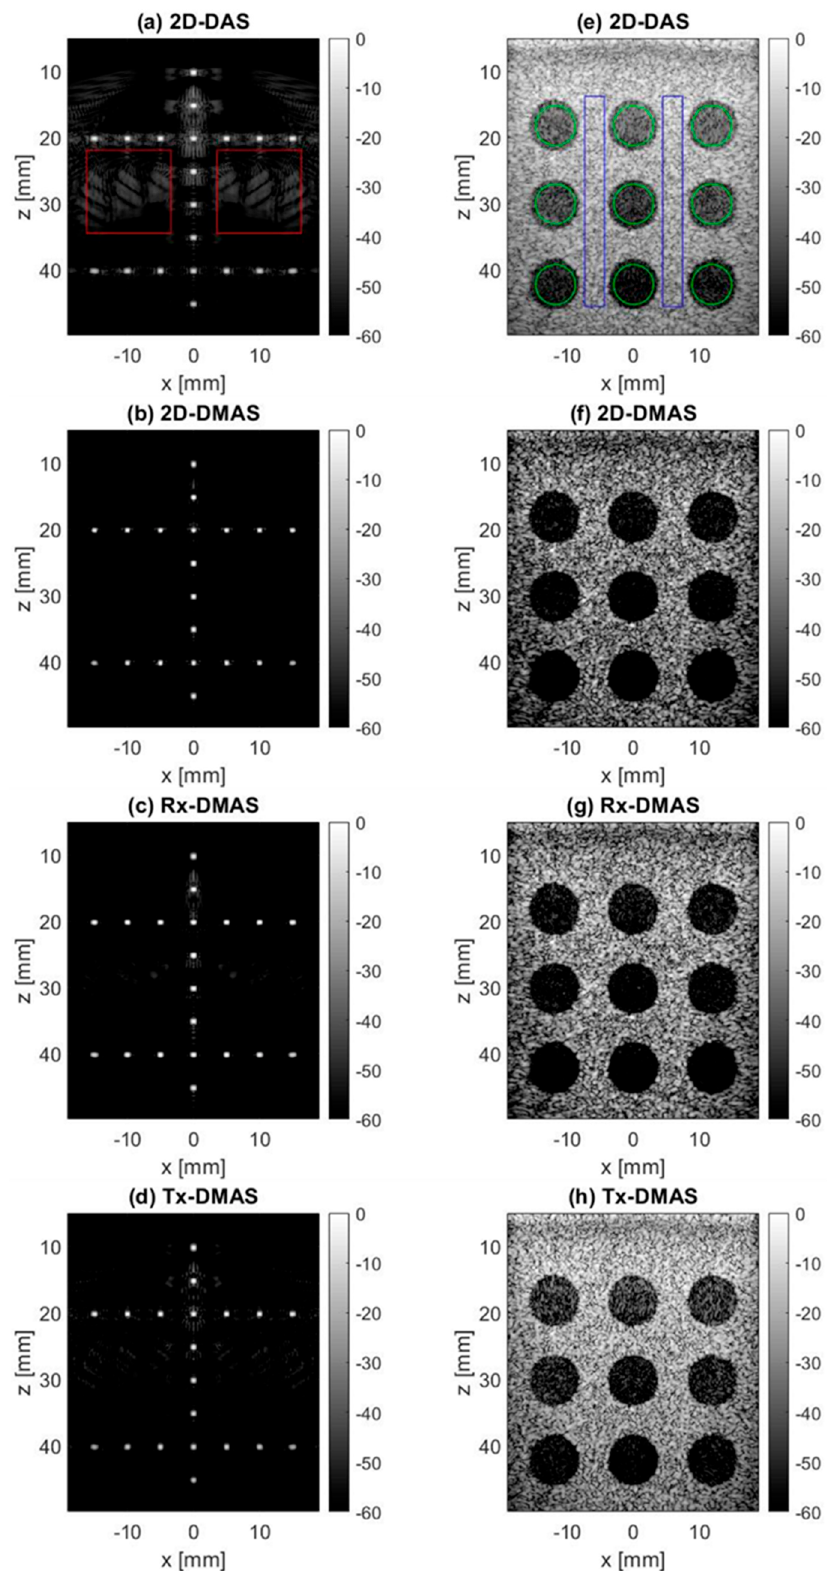
Figure 1. Simulated B-mode images of wire reflectors and anechoic cysts for two-dimensional delay-and-sum (2D-DAS), Rx-DMAS, Tx-DMAS, and two-dimensional delay-multiply-and-sum (2D-DMAS) beamforming: The p value in DMAS beamforming is fixed to 2.0.